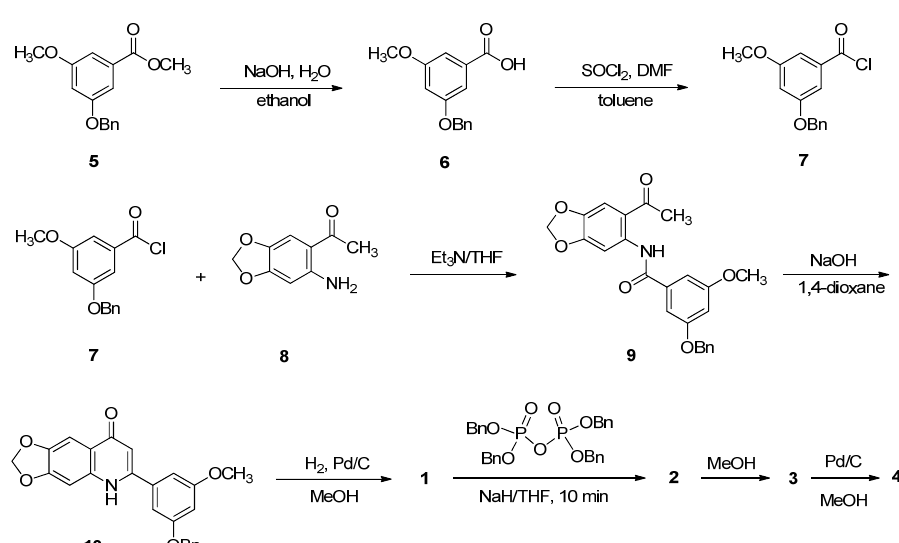
Scheme 1. Synthesis of compounds 1 – 4